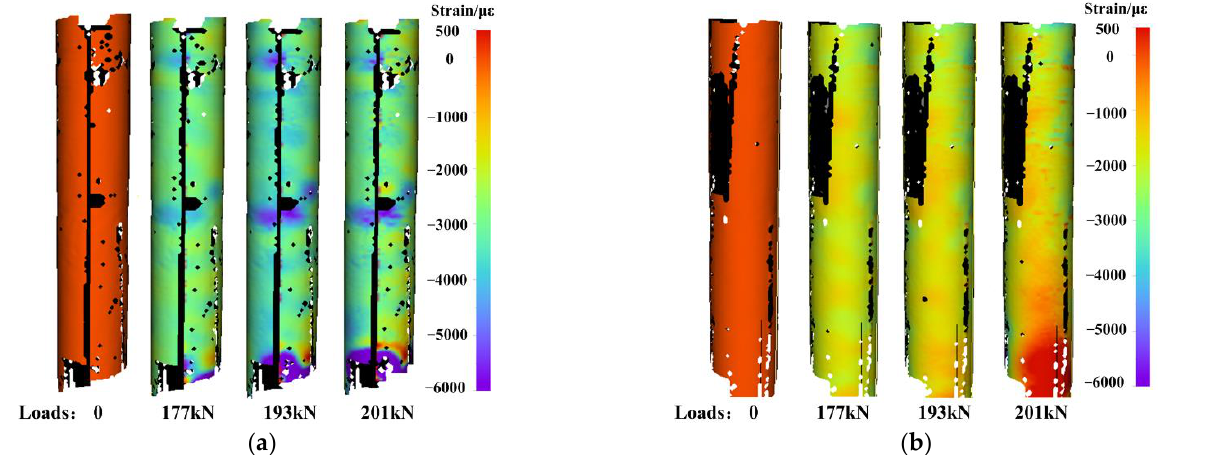
Figure 23. Strain evolution on: ( a ) concave side; ( b ) convex side under different axial loads.